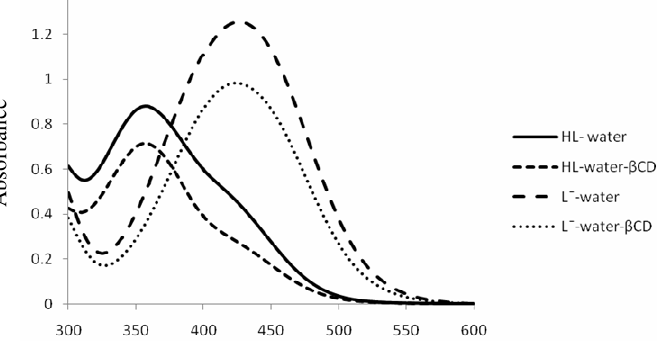
Figure 4 . Sample spectrum of the calculated pure spectra of all species in pure water and water-cyclodextrin (6 × 10 -3 mol L -1 )